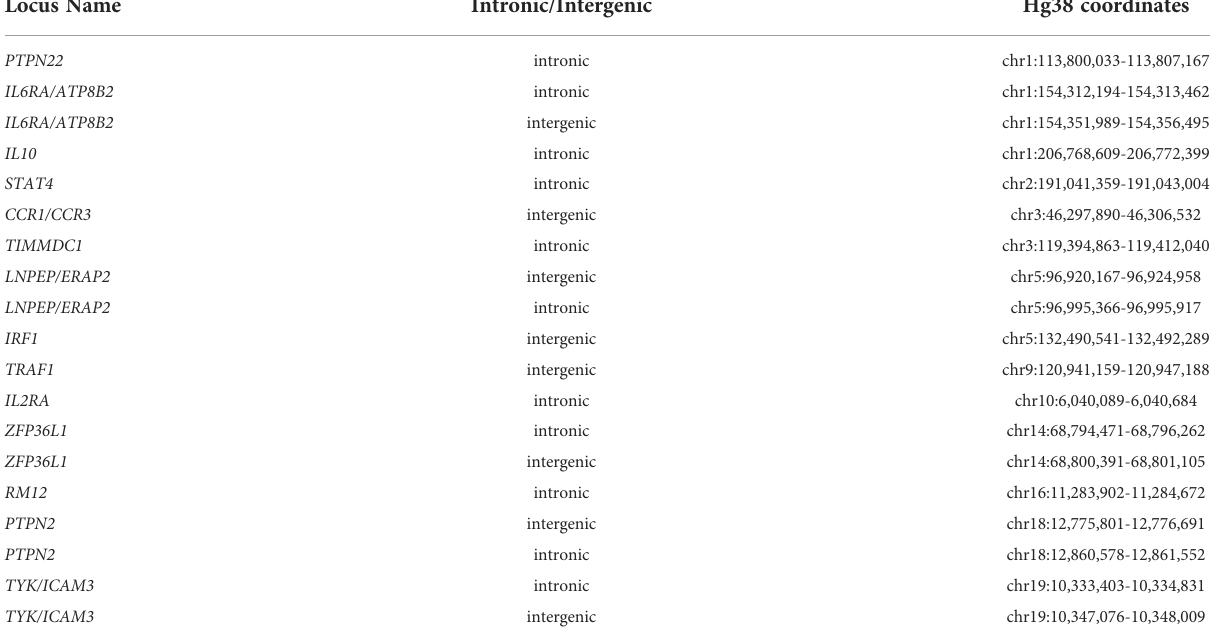
TABLE 4 Chromatin coordinates of enhancers identi fi ed by MPRA in K562+IFNG in